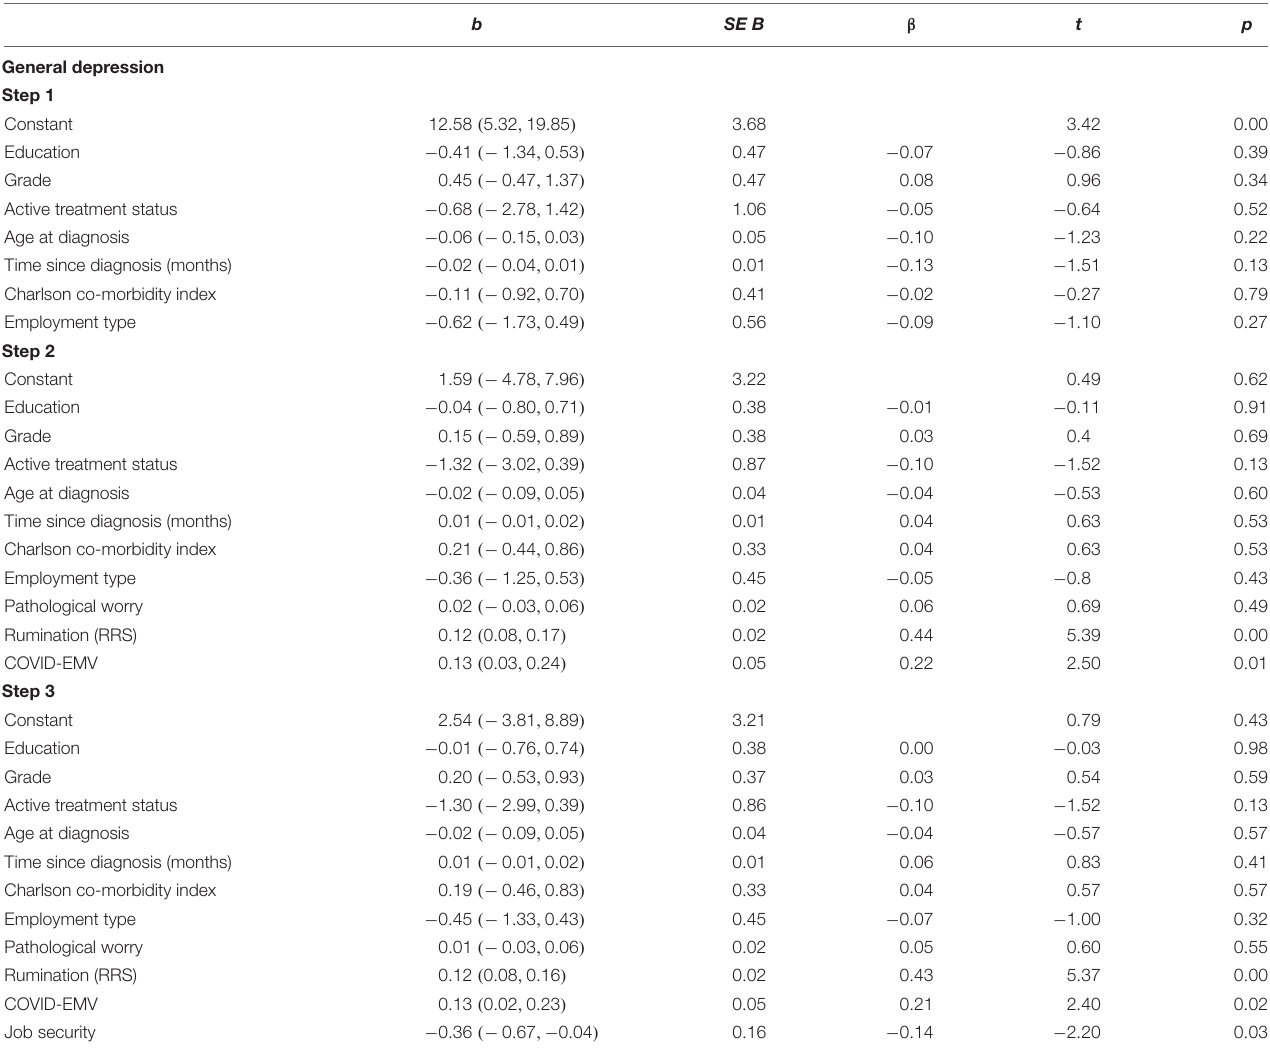
TABLE 3 | Hierarchical regression for the predictors of depression.